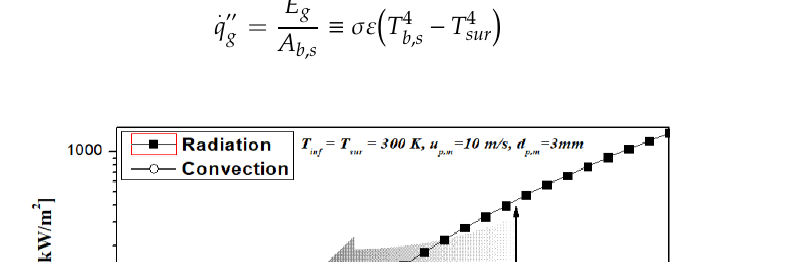
Figure 5. Comparison of the convection and the radiation of the particle.